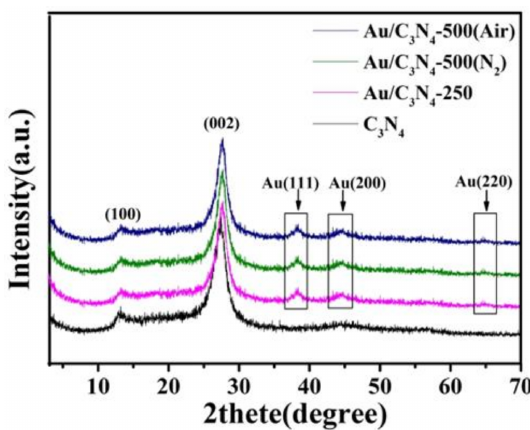
Figure 2. XRD patterns of C 3 N 4 , Au/C 3 N 4 -250, Au/C 3 N 4 -500(N 2 ), and Au/C 3 N 4